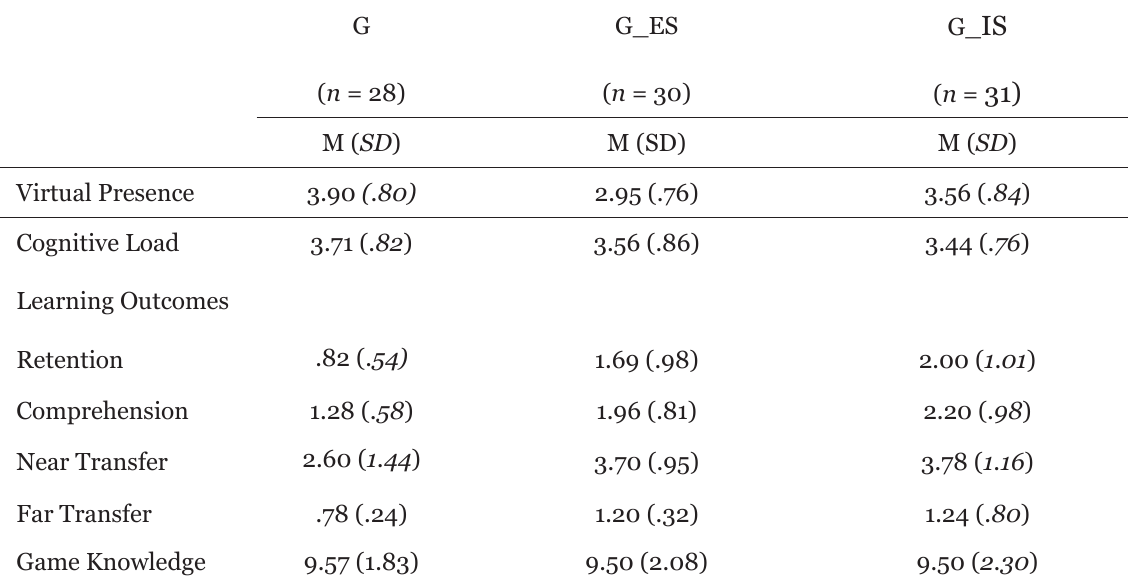
Means (and Standard Deviations) for Virtual Presence, Cognitive Load, and Sum Scores for Learning Outcomes of the Three